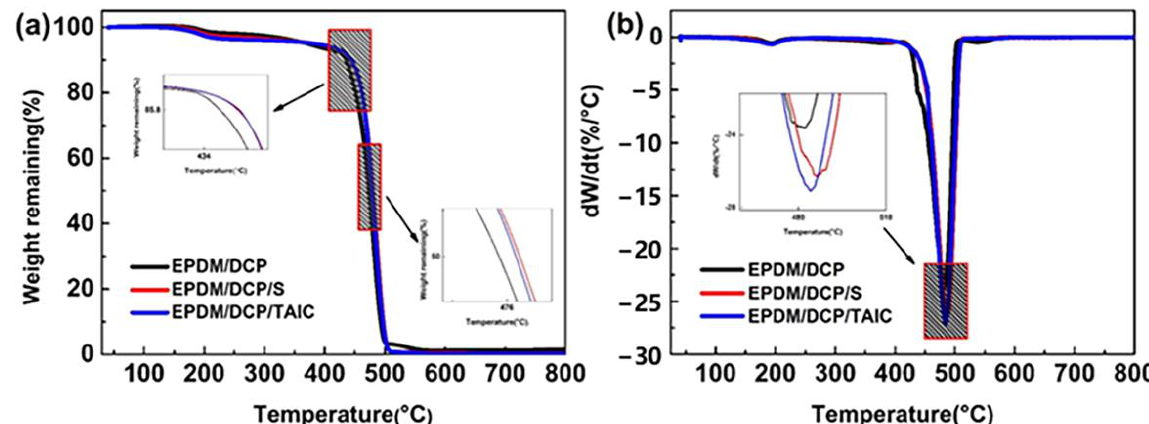
Figure 9. The ( a ) TGA curves and ( b ) DTG curves of EPDM rubbers. Table 3. The TGA results of EPDM rubbers.